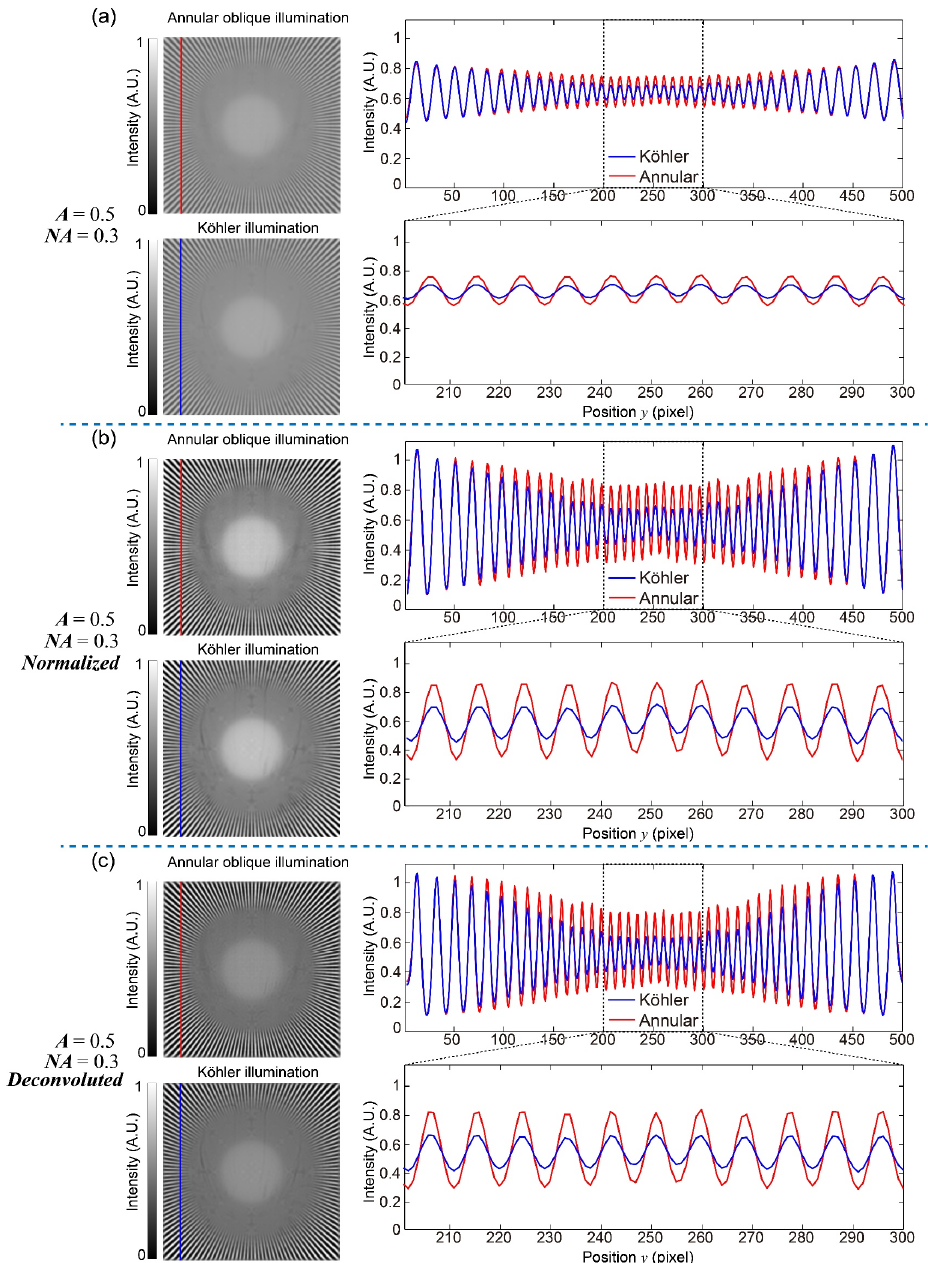
Figure 12. Simulated images: ( a ) simulated images with intensity distributions at the 50th column, and intensity distributions of 201 to 300 pixels at the 50th column; ( b ) normalized images of ( a ) with intensity distributions at the 50th column, and intensity distributions of 201 to 300 pixels at the 50th column; ( c ) deconvoluted images of ( b ) with intensity distributions at the 50th column and intensity distributions of 201 to 300 pixels at the 50th column.